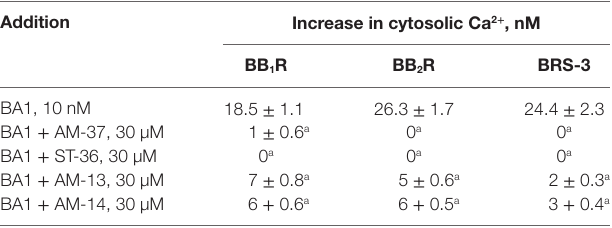
TaBle 2 | Increases in cytosolic Ca 2 + using human lung cancer cells transfected with bombesin